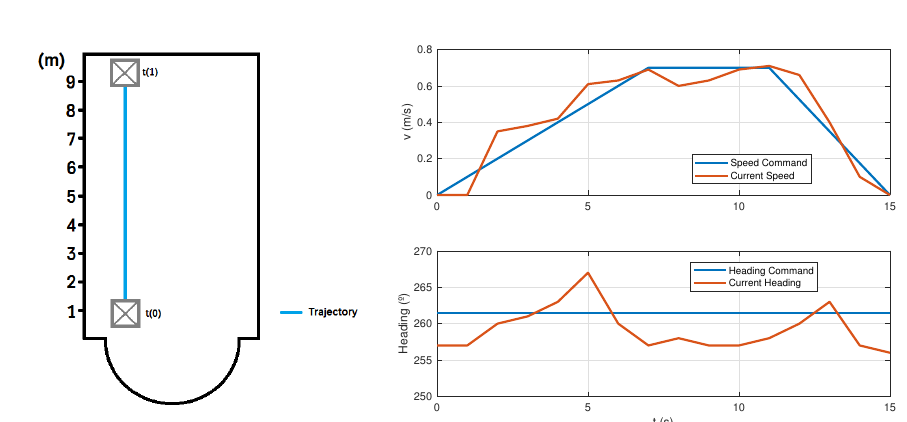
Figure 12. Straight-line test results. Position of the Strider V1.0 ( Left ) and current and reference speed and heading values during test ( Right